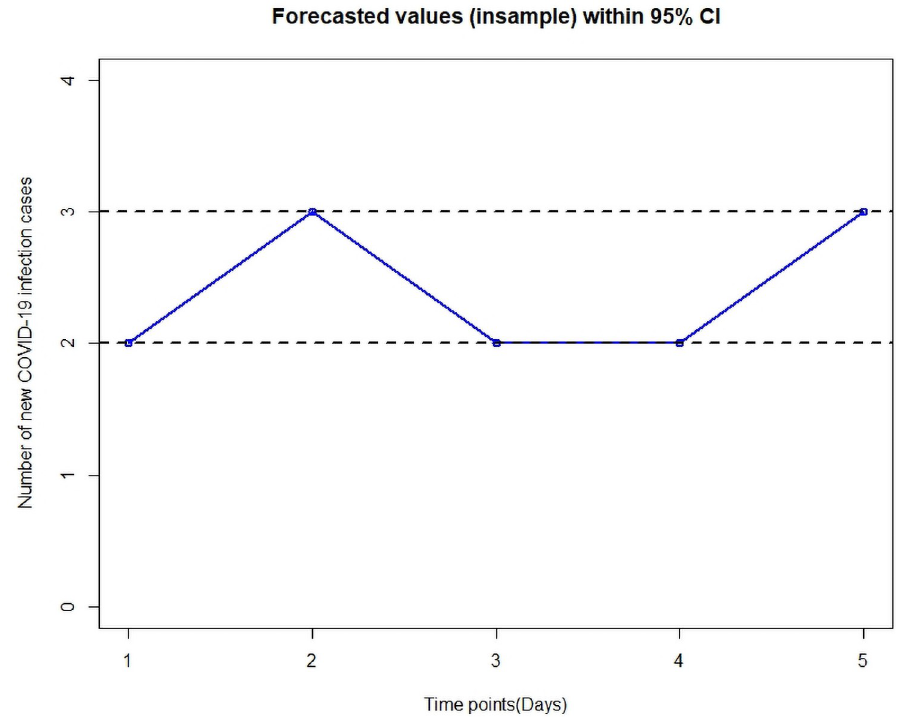
Fig 6. Forecasted values (in-sample) with 95% confidence